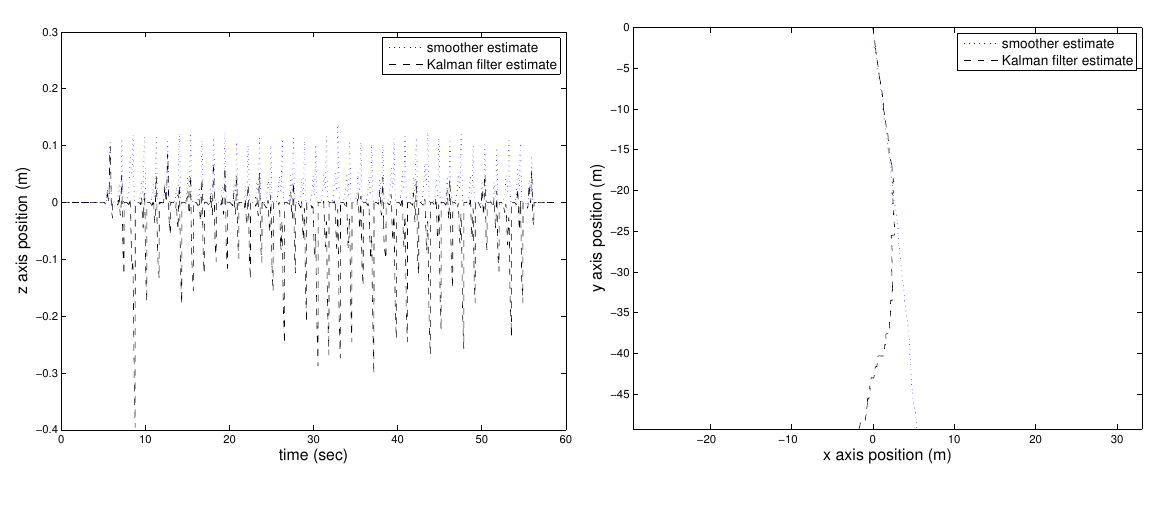
Figure 5. Estimated position (50-m walk): z -axis position ( Left ) and xy -axis position ( Right ).